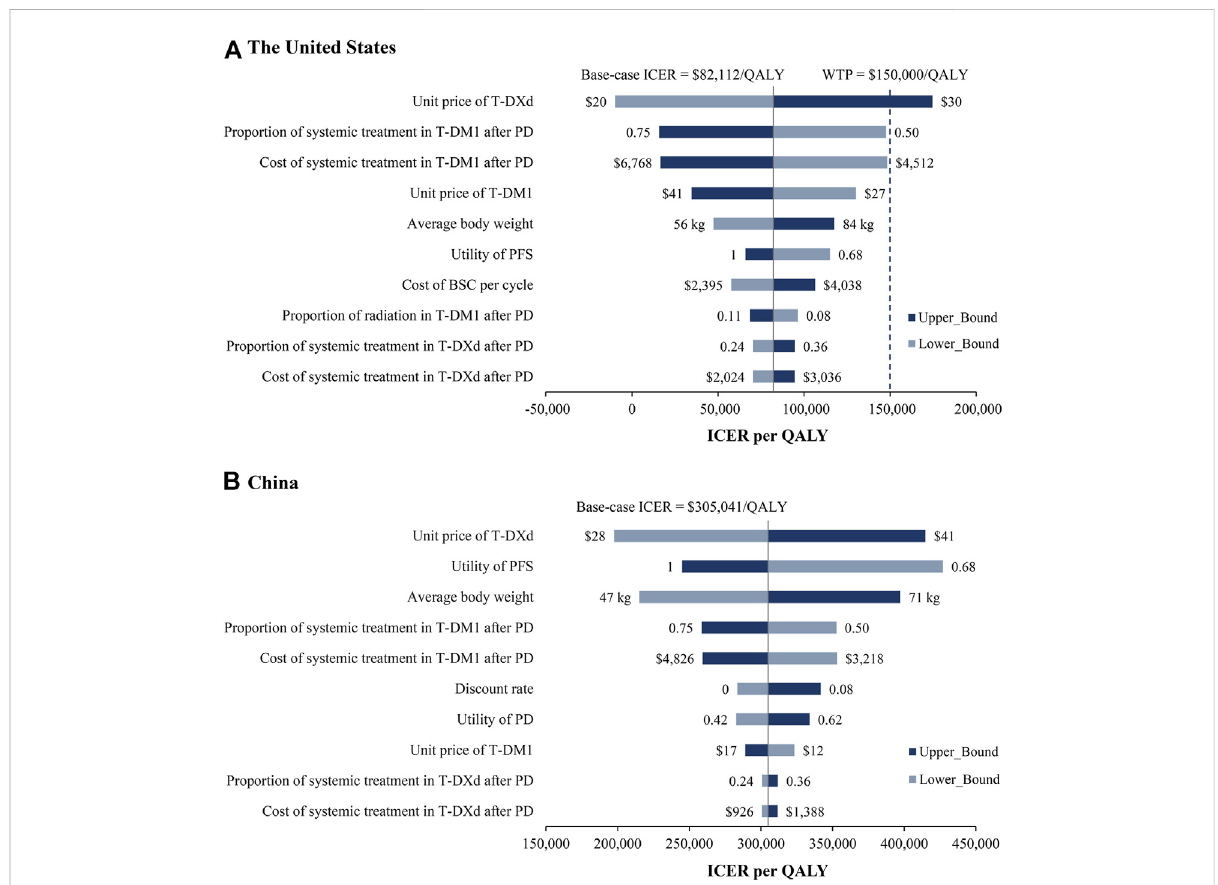
FIGURE 2 One-way sensitivityanalyses.Tornado diagrams show thetop10parametersthat havethegreatest impactontheresults fromtheperspectives of the US (A) and China (B) . BSC, best support care; ICER, incremental cost-effectiveness ratio; PD, progression disease; PFS, progression-free survival; QALY, quality-adjusted life